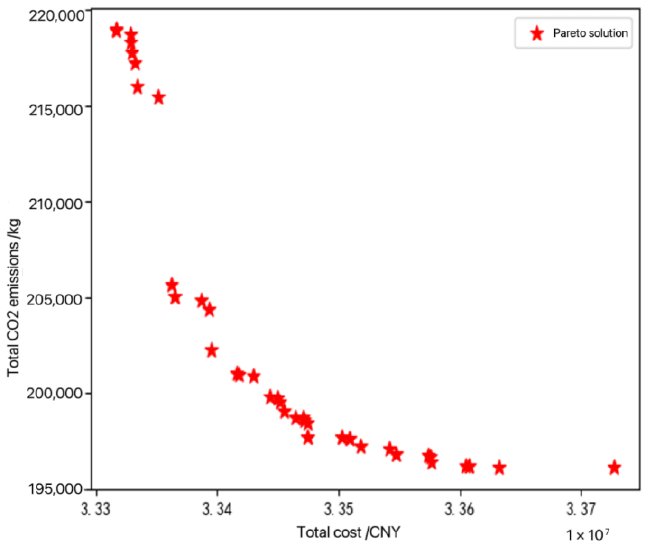
Figure 15. Total cost and carbon dioxide emissions Pareto solution set.